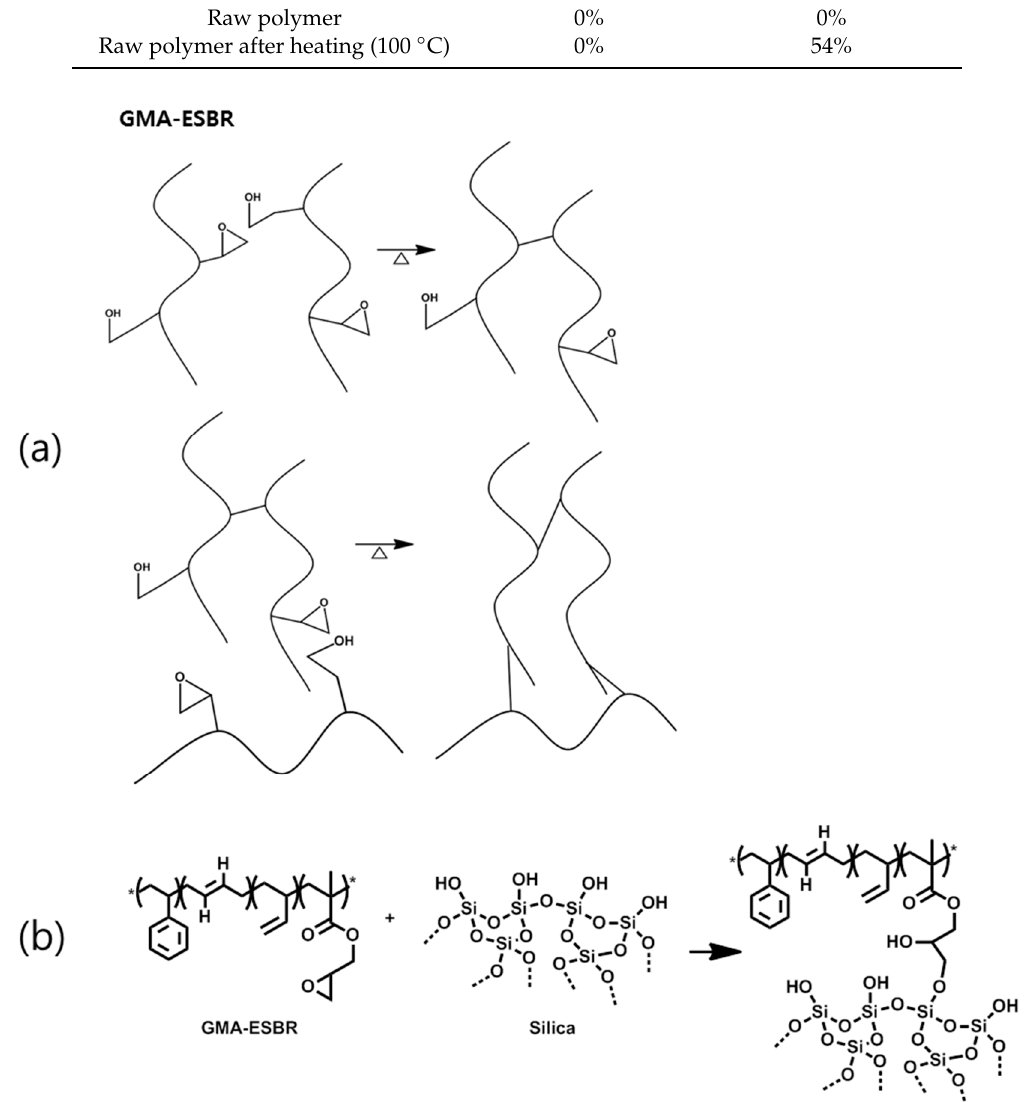
Figure 2. Suggested mechanism of ( a ) gelation based on epoxy ring opening and ( b ) silica-GMA coupling reaction.